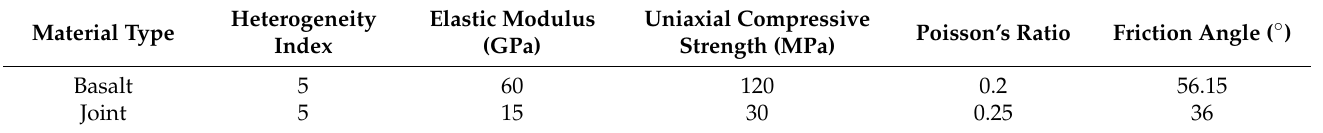
Table 2. The physical-mechanical parameter values for numerical simulation.